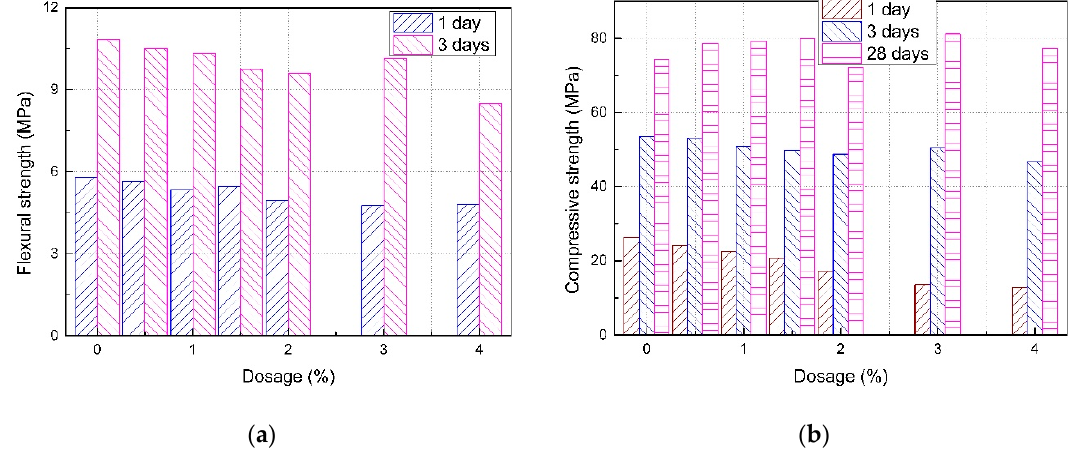
Figure 6. Strength of SLM with different dosages of RP: ( a ) flexural strength; ( b ) compressive